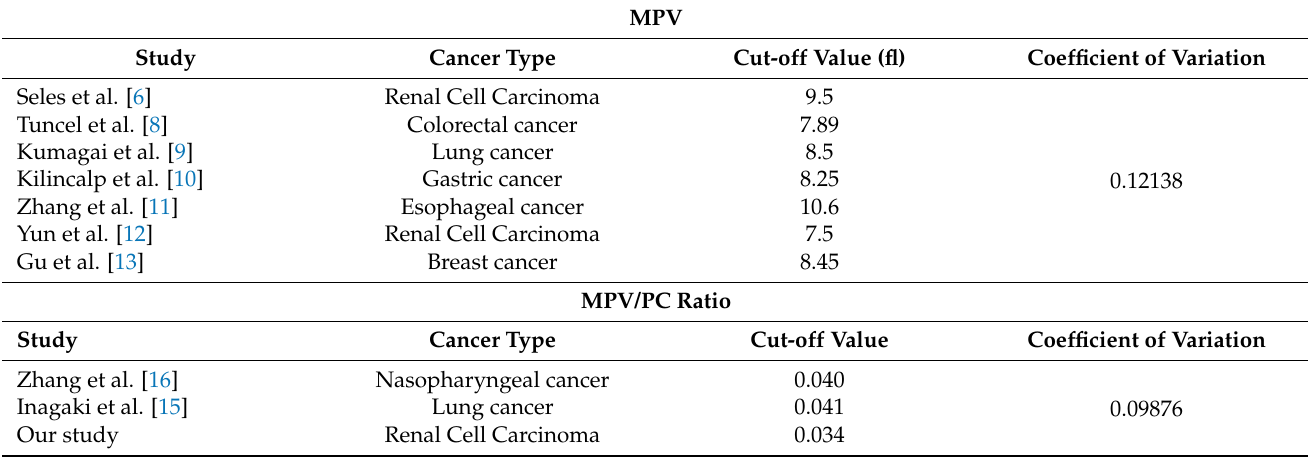
Table 3. The cut-off values of MPV and MPV/PC ratio to determine prognosis in current studies. MPV/PC: mean platelet volume/platelet